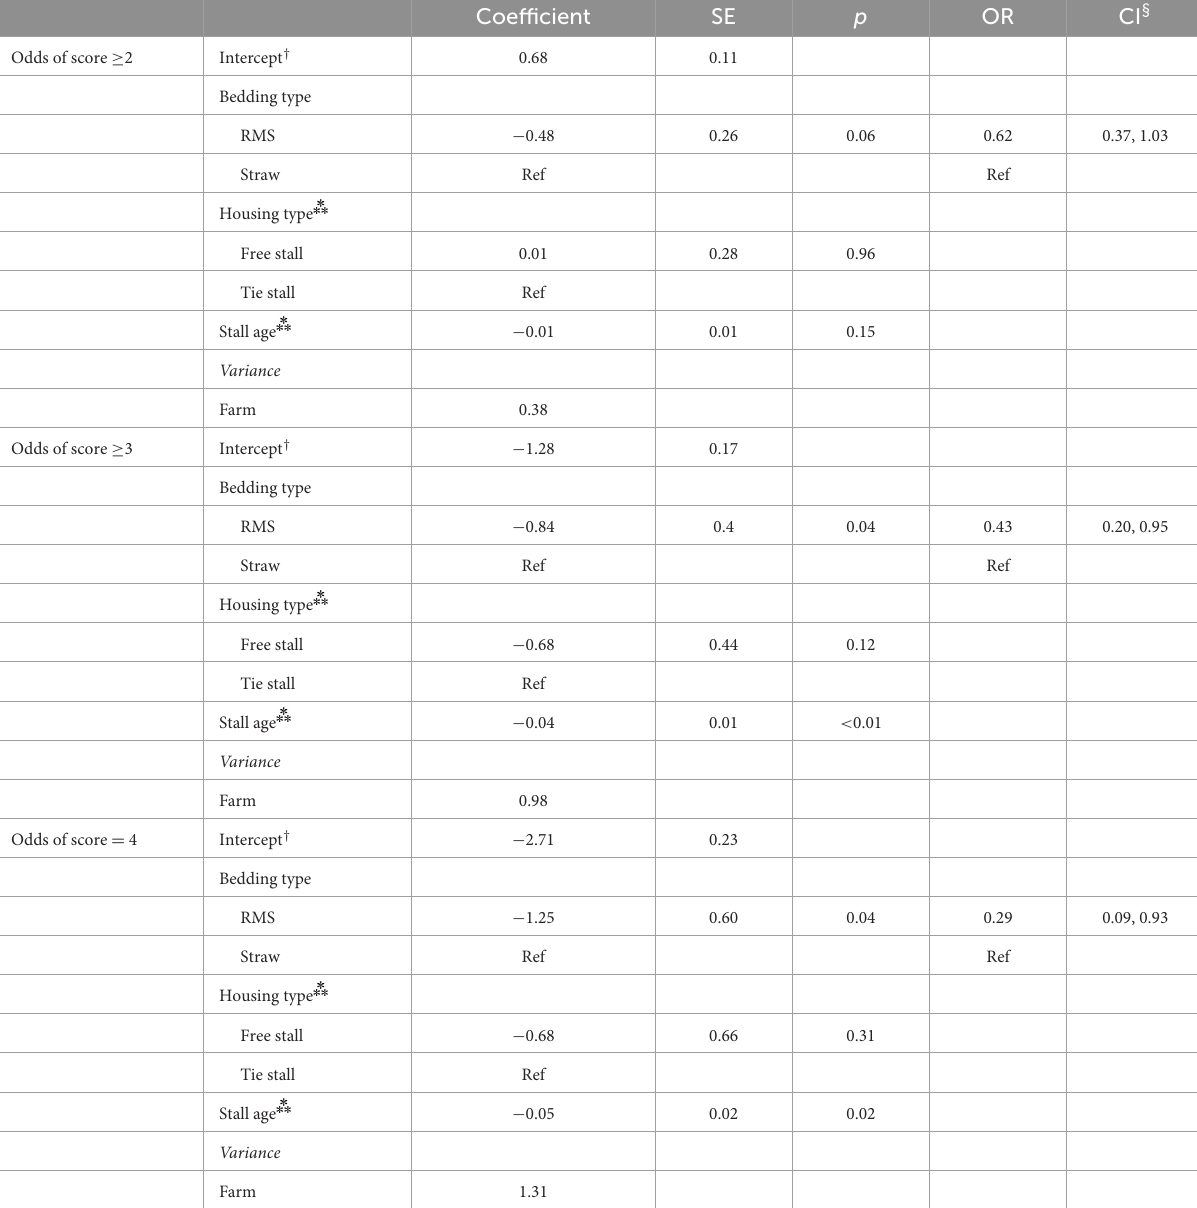
TABLE 3 Udder hygiene odds ratio comparing cows housed on recycled manure solids bedding to straw-bedded cows, and estimated using continuation-ratio mixed model. Coefficient SE